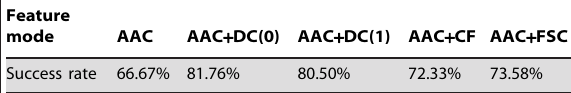
Table 4 . The jackknife success rates obtained in identifying the NR subfamilies by separately using different features on the benchmark dataset of Supporting Information